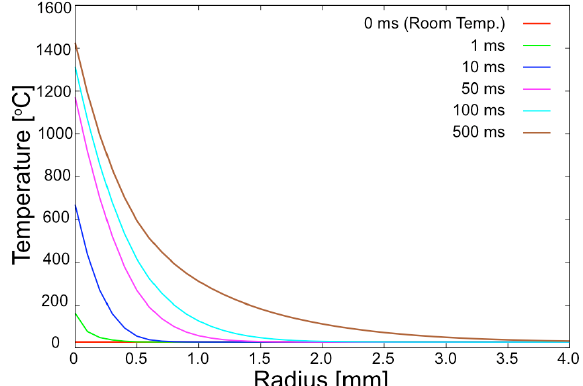
Figure 2. The temperature as a function of radius from the center of the CW laser spot on the tape target, calculated by a time-dependent thermal simulation.